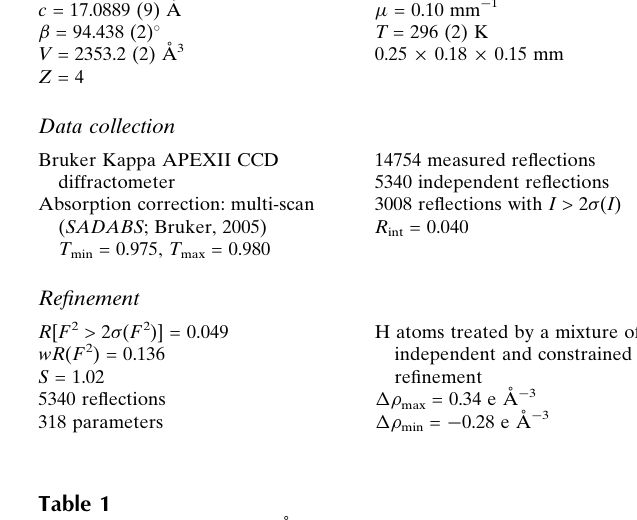
Hydrogen-bond geometry (A˚ , (cid:1) ). D —H (cid:4)(cid:4)(cid:4)